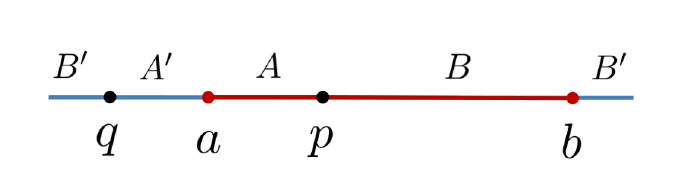
Figure 2: Single interval optimization. (a) The full interval AB = [ a , b ] is denoted by the red line. The coordinate for the partition point of AB is p and the one for A (cid:48) B (cid:48) is q